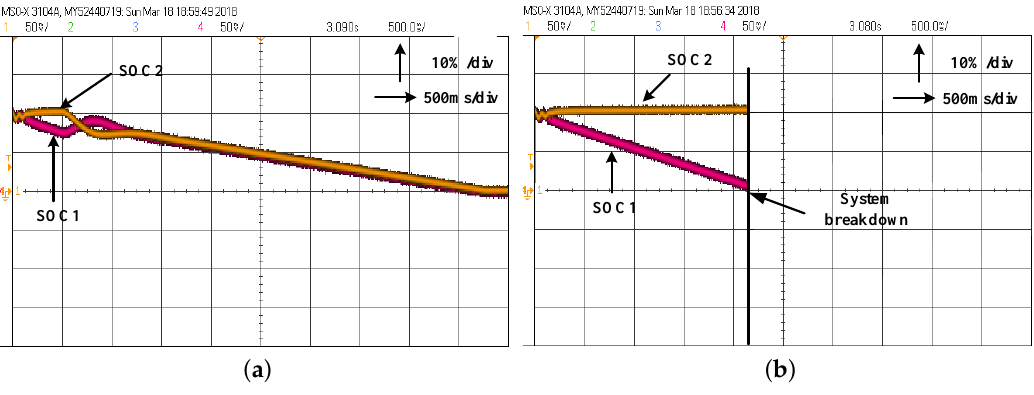
Figure 13. Test results of Case 2: ( a ) SOCs of storages when BPCs are controlled by proposed strategy; and ( b ) SOCs of storages when BPCs are controlled without proposed